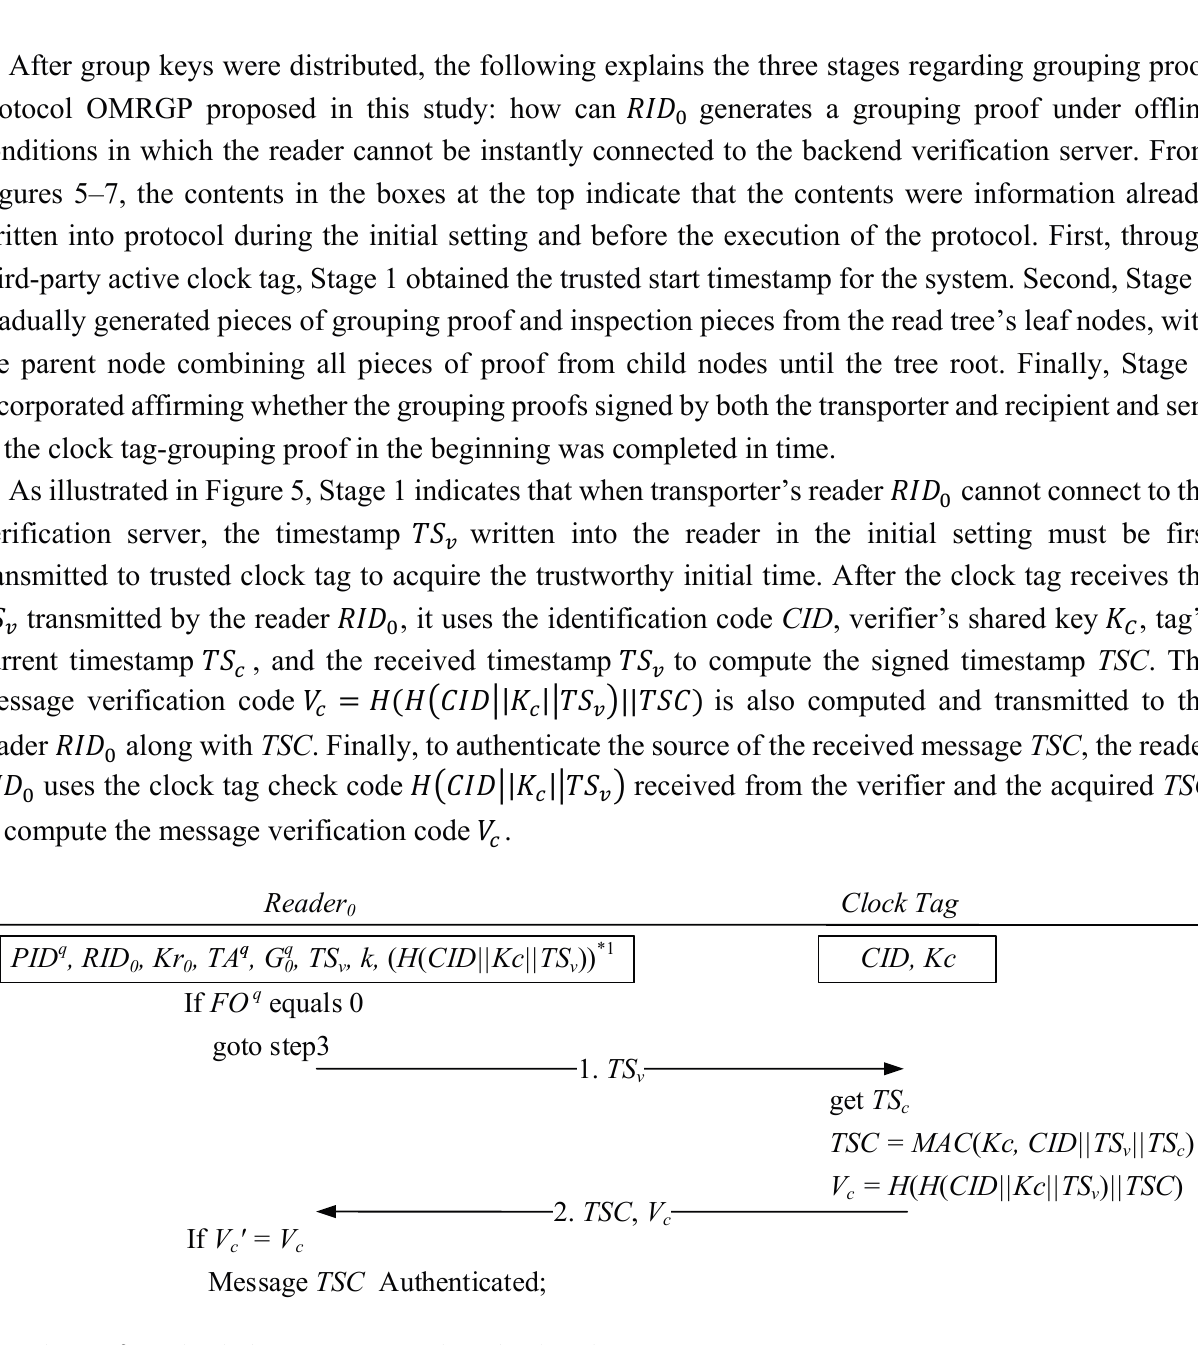
Figure 5. Signed timestamp acquired from trustworthy clock